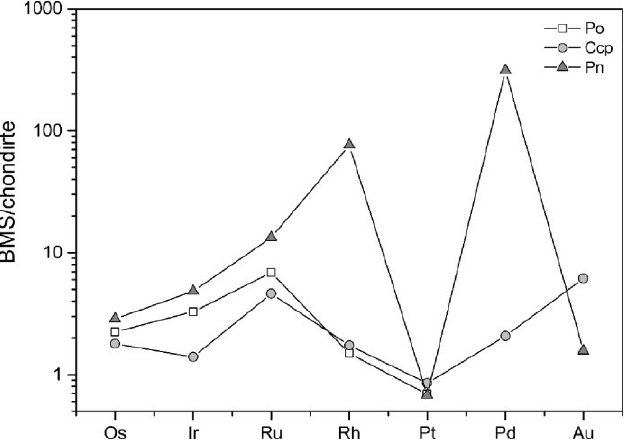
Figure 9. Chondrite normalized median PGE concentrations (from LAICP-MS) hosted by BMS. Normalization values were taken from McDonough and Sun [70].